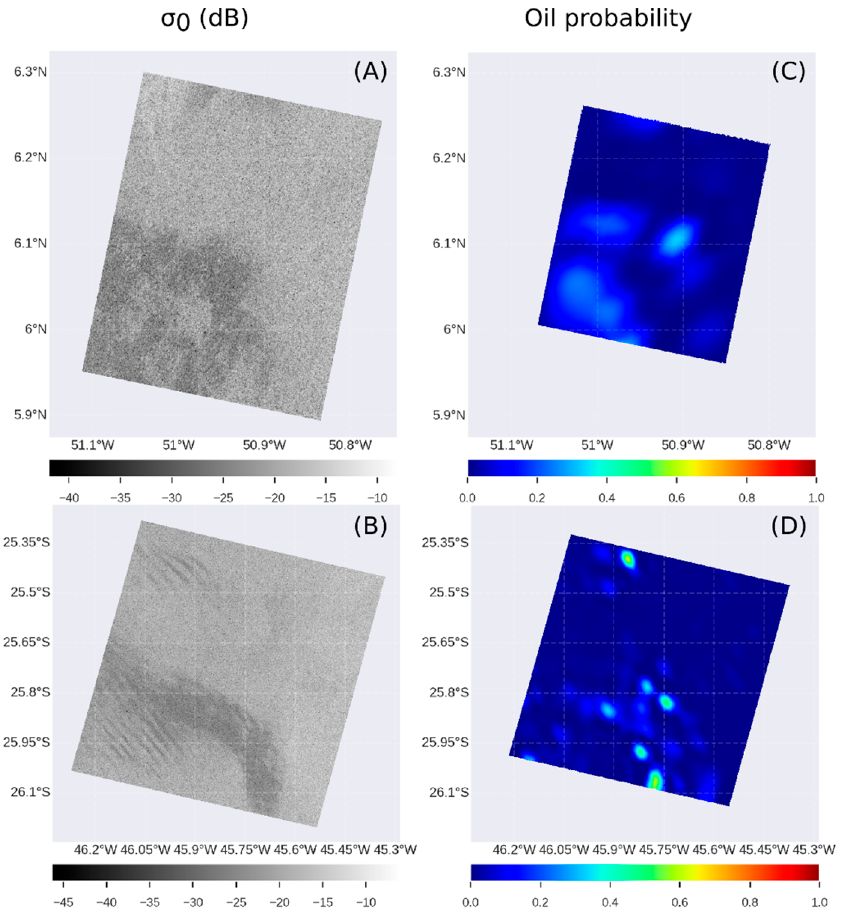
Figure 10. Rain cell ( A ) and wind ( B ) images and their associated oil presence probability as calculated from a two-class random forest model (respectively, C and D ). Although there were black spots in the SAR images, our algorithm did not associate these features with oil spills.